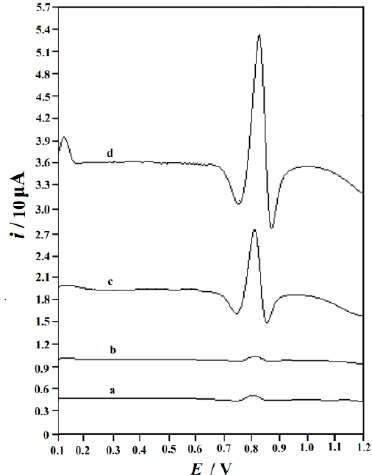
Figure 4. Second-order derivative linear scan voltammograms of 0.1 mM SY recorded at GCE ( a ), GO/GCE ( b ), ERGO/GCE ( c ) and MnO 2 NRs-ERGO/GCE ( d ) in 0.3 M citric acid-sodium citrate buffer (pH 4.5). Accumulation potential: 0.1 V, accumulation time: 180 s, scan rate 0.1 V/s.